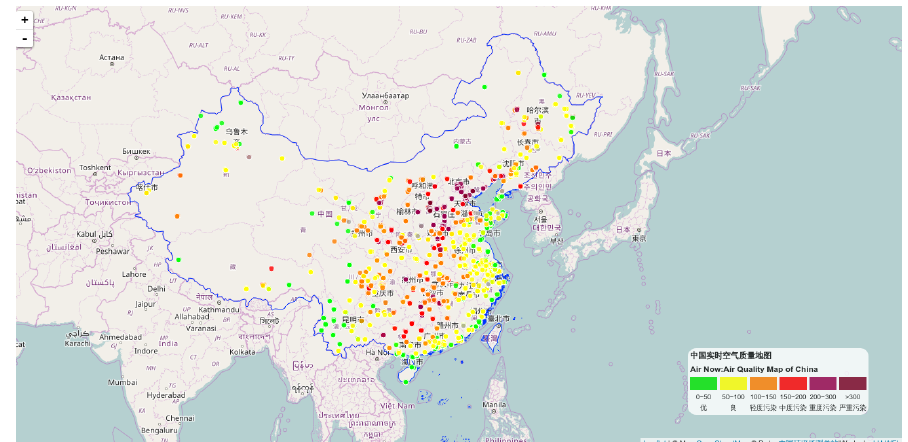
Figure 6. Air Quality Monitoring Network in China. This image shows a snapshot air quality map of monitoring stations in China, at 8:00, 12 December 2016. (refer to: